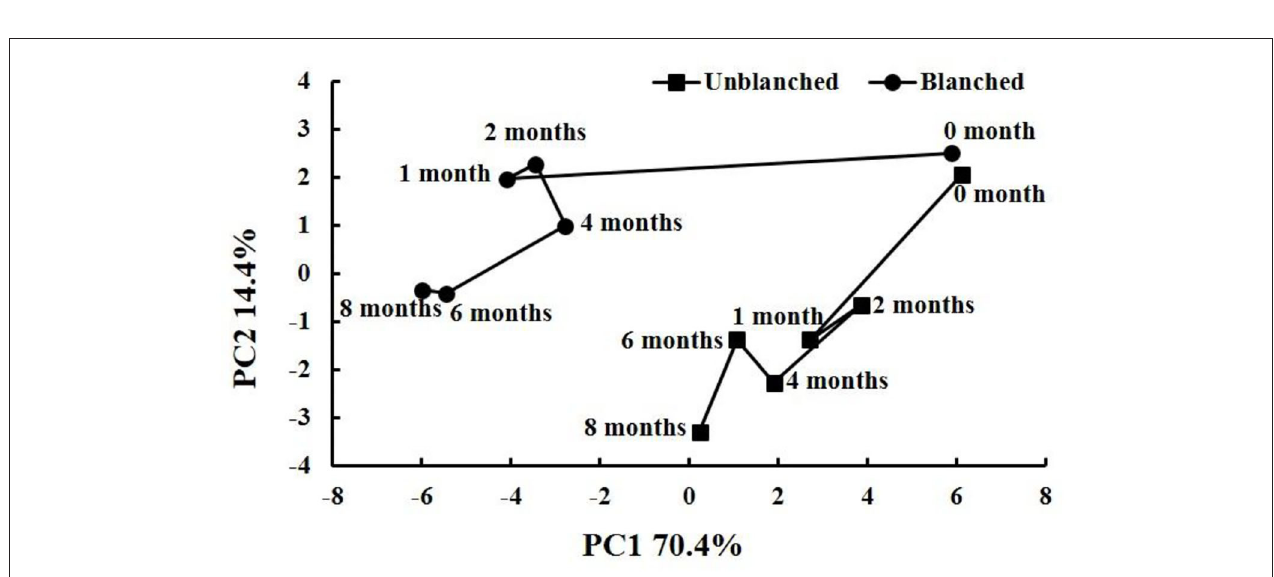
FIGURE 6 | Time-related trajectory plot showing the dynamic time-related responses of nutritional qualities in baby mustard lateral buds during frozen storage at − 20 ◦ C. Unblanched represents no blanching before freezing; Blanched represents blanching before